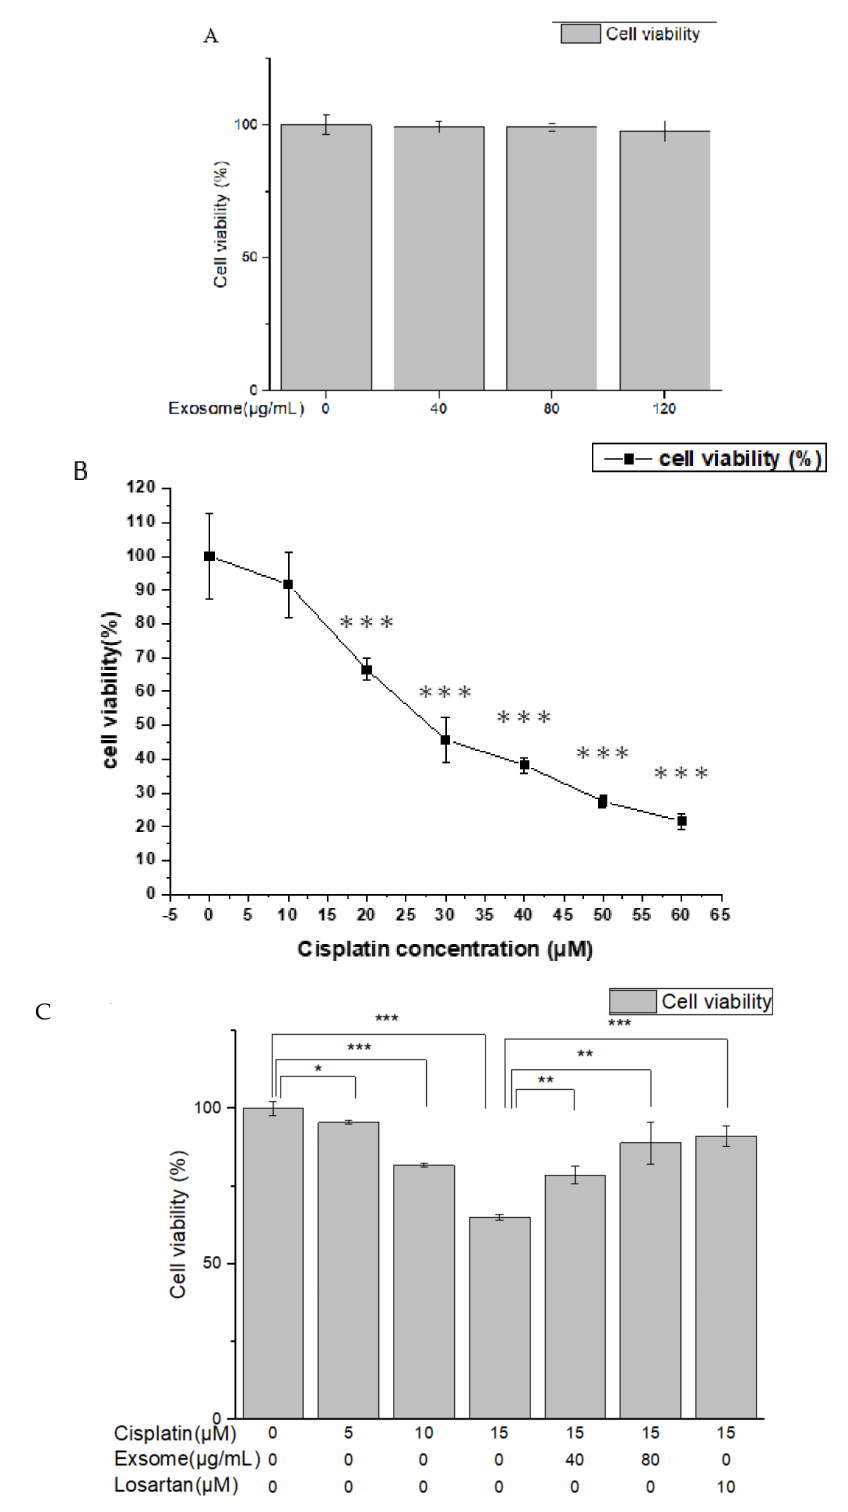
Figure 3. Cell viability of NRK-52E cells treated with various concentrations of SCAP-ex ( A ) and cisplatin ( B ). Cell survival of NRK-52E cells pretreated with 40 or 80 µ g/mL SCPA-ex or 10 µ M losartan and subsequently treated with 15 µ M cisplatin ( C ). Values are expressed as mean ± SD ( n = 3), * p < 0.05; ** p < 0.01; *** p < 0.001. SCAPs, stem cells from the apical papilla; SCAP-ex, SCAP-derived